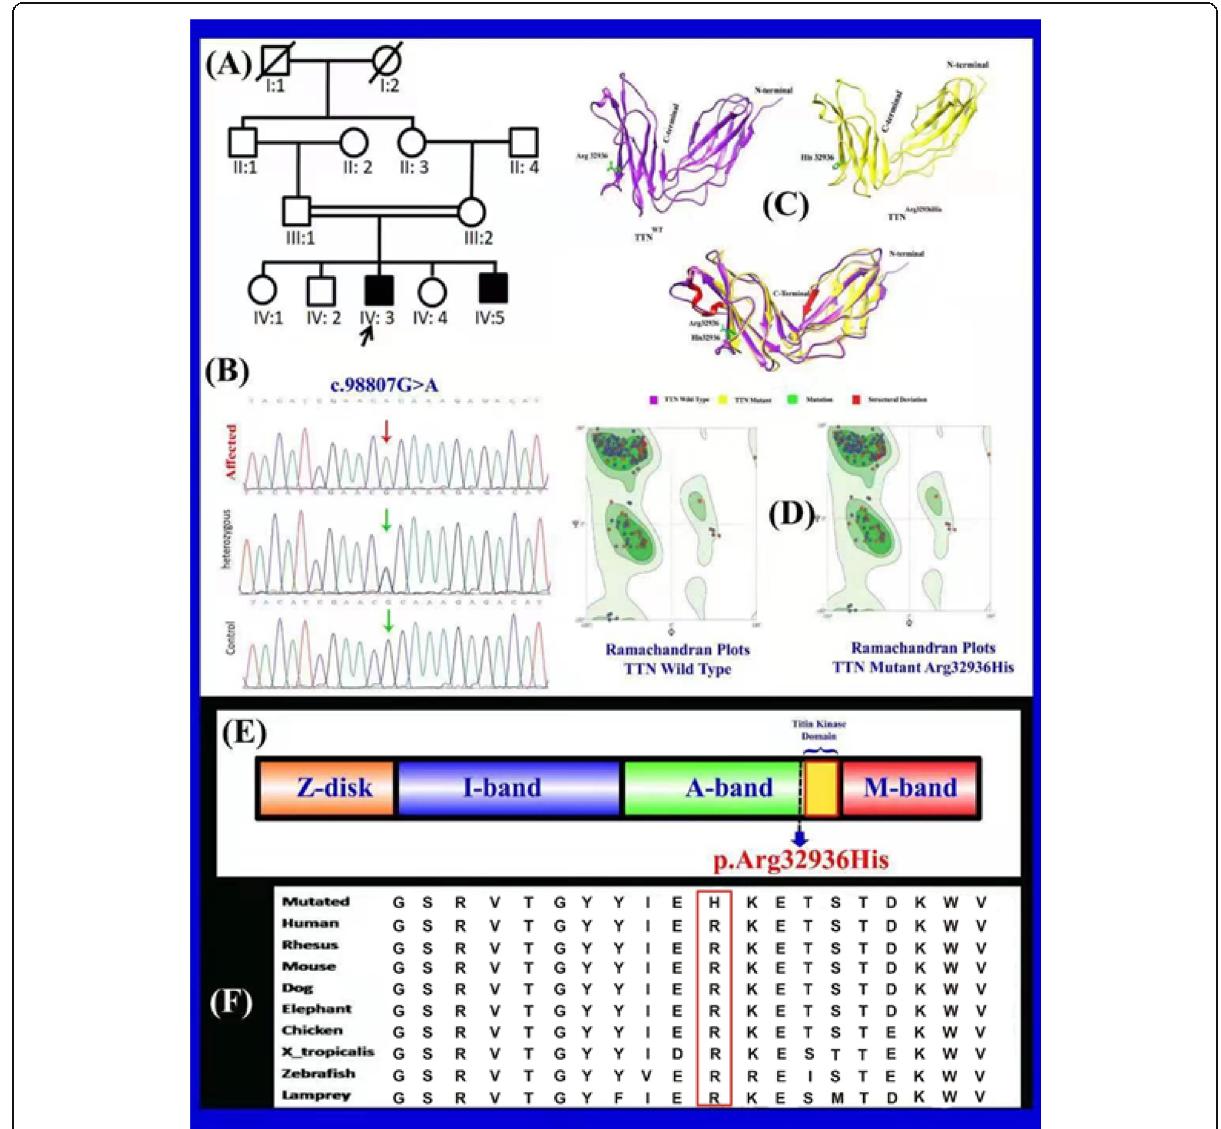
Fig. 1 a A consanguineous pedigree showing two affected members (IV:3 and IV:5) in the fourth generation having limb girdle muscular dystrophy. Affected individuals in the pedigree are shown with shaded symbols and unaffected with open symbols. Double lines indicate consanguineous union. b Sequence chromatogram of the TTN gene is showing segregation of c.98807G>A; p. Arg32936His in all family members c Ribbon representation of three-dimensional structure of human titin with close-up view of mutant (right) and wild type (left) at position 32,936 showing the local conformation induced by the substitution of arginine by histidine. d Ramachandran plots of wild and mutant types. e Schematic view of the functional domain of the TTN gene and localization of known mutation (Arg32936His). The novel missense variant p. Arg32936His reported here is indicated in red localized in the FN3 domain 128, which is situated in the distal A-band region. f The panel also shows the evolutionary conservation of Arg32936 across different